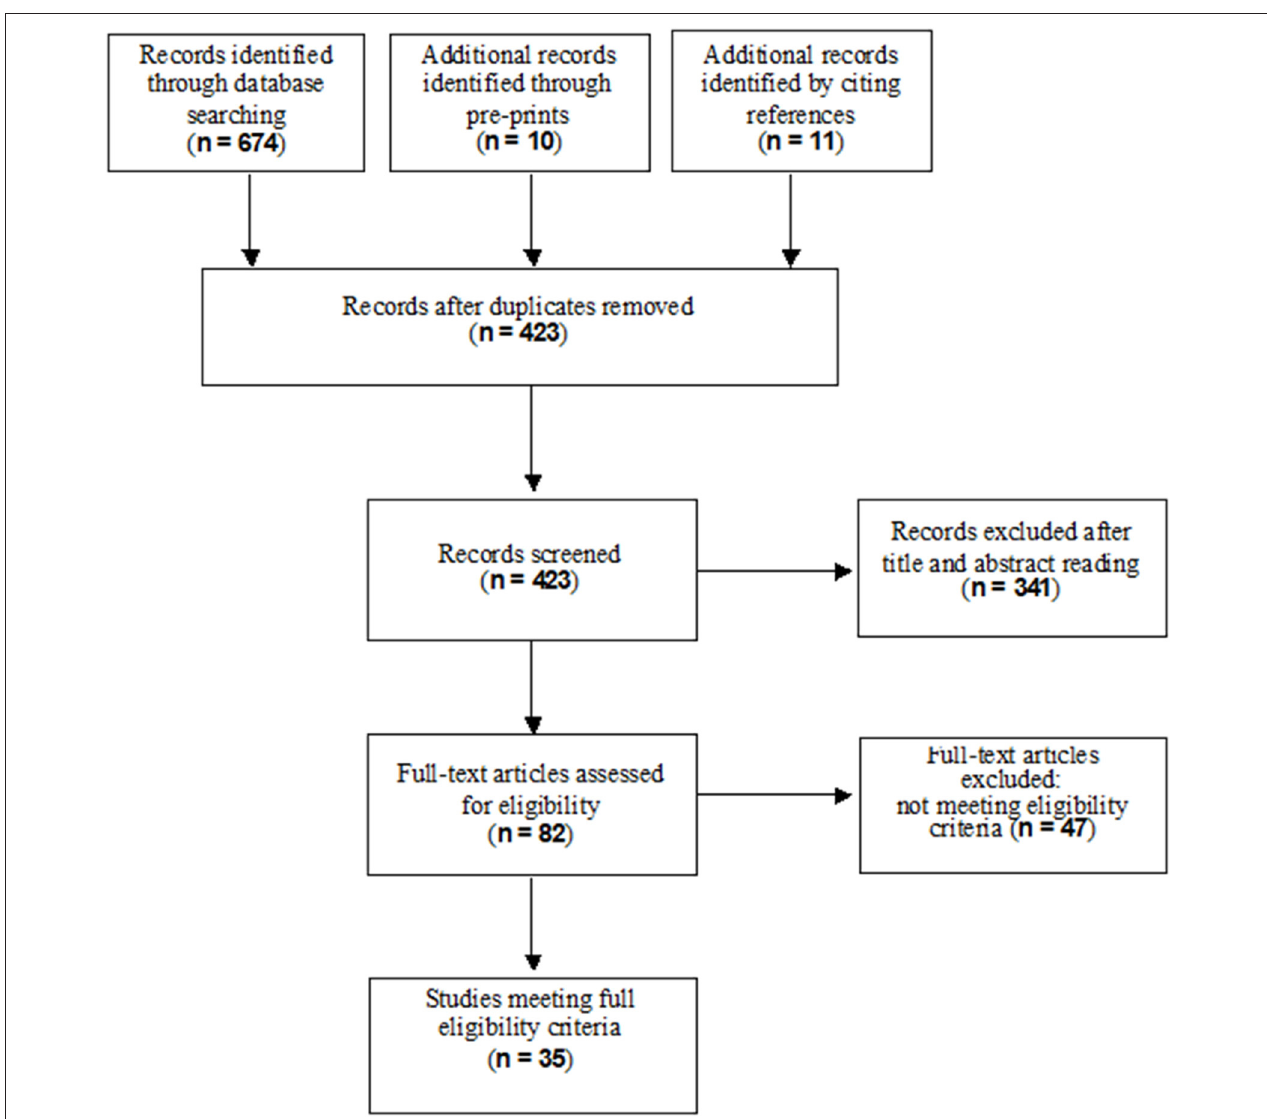
FIGURE 1 | Flow diagram of study selection